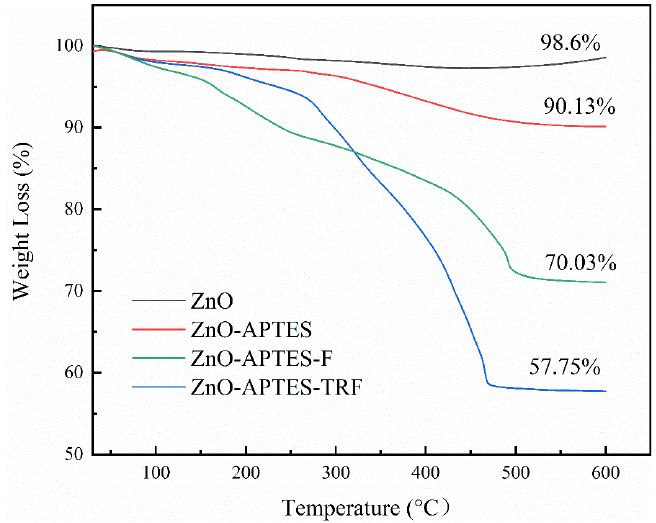
Figure 5. TGA curve